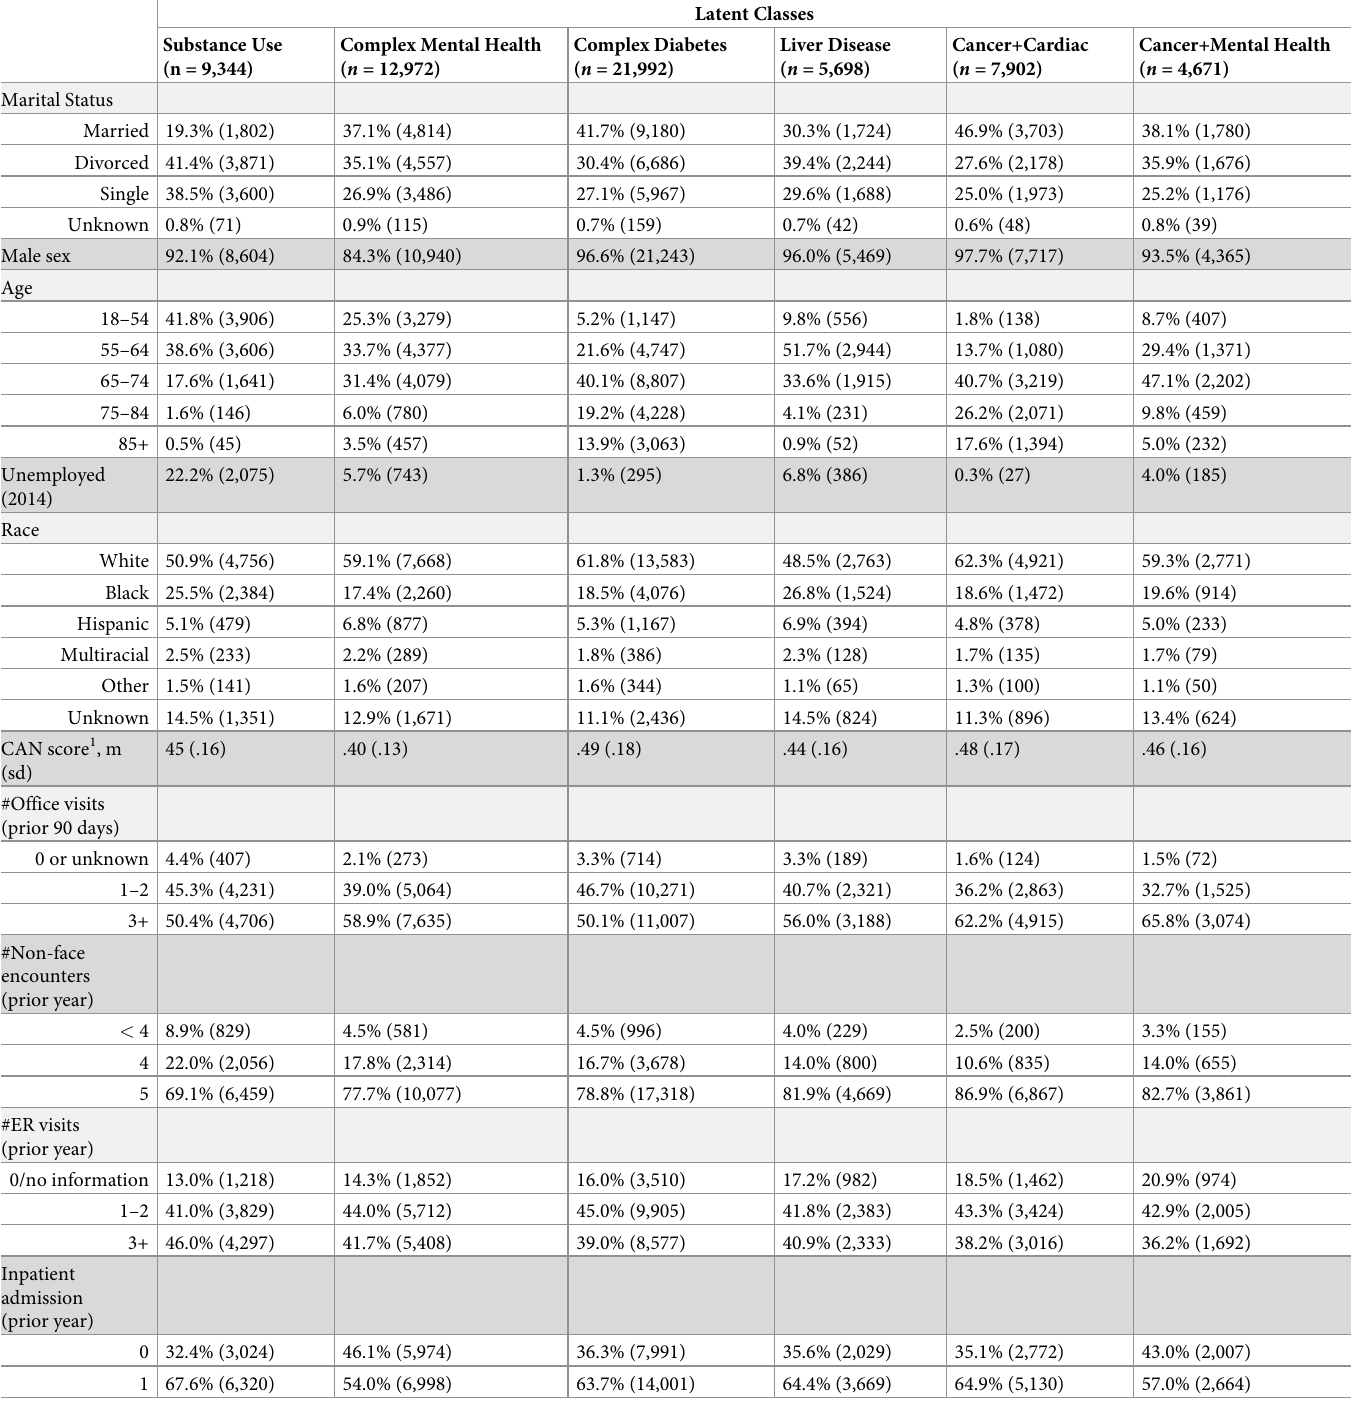
Table 3. Descriptive demographic and utilization information within subgroups, %( n